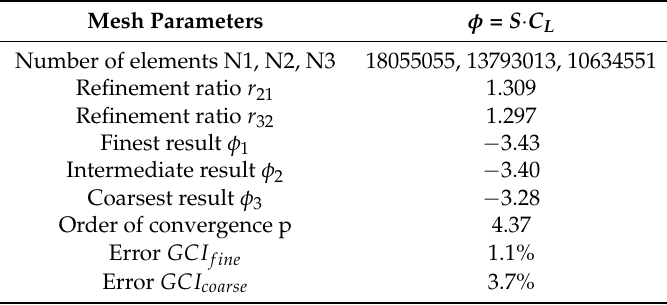
Table 1. Grid Convergence Index result of the meshes studied.